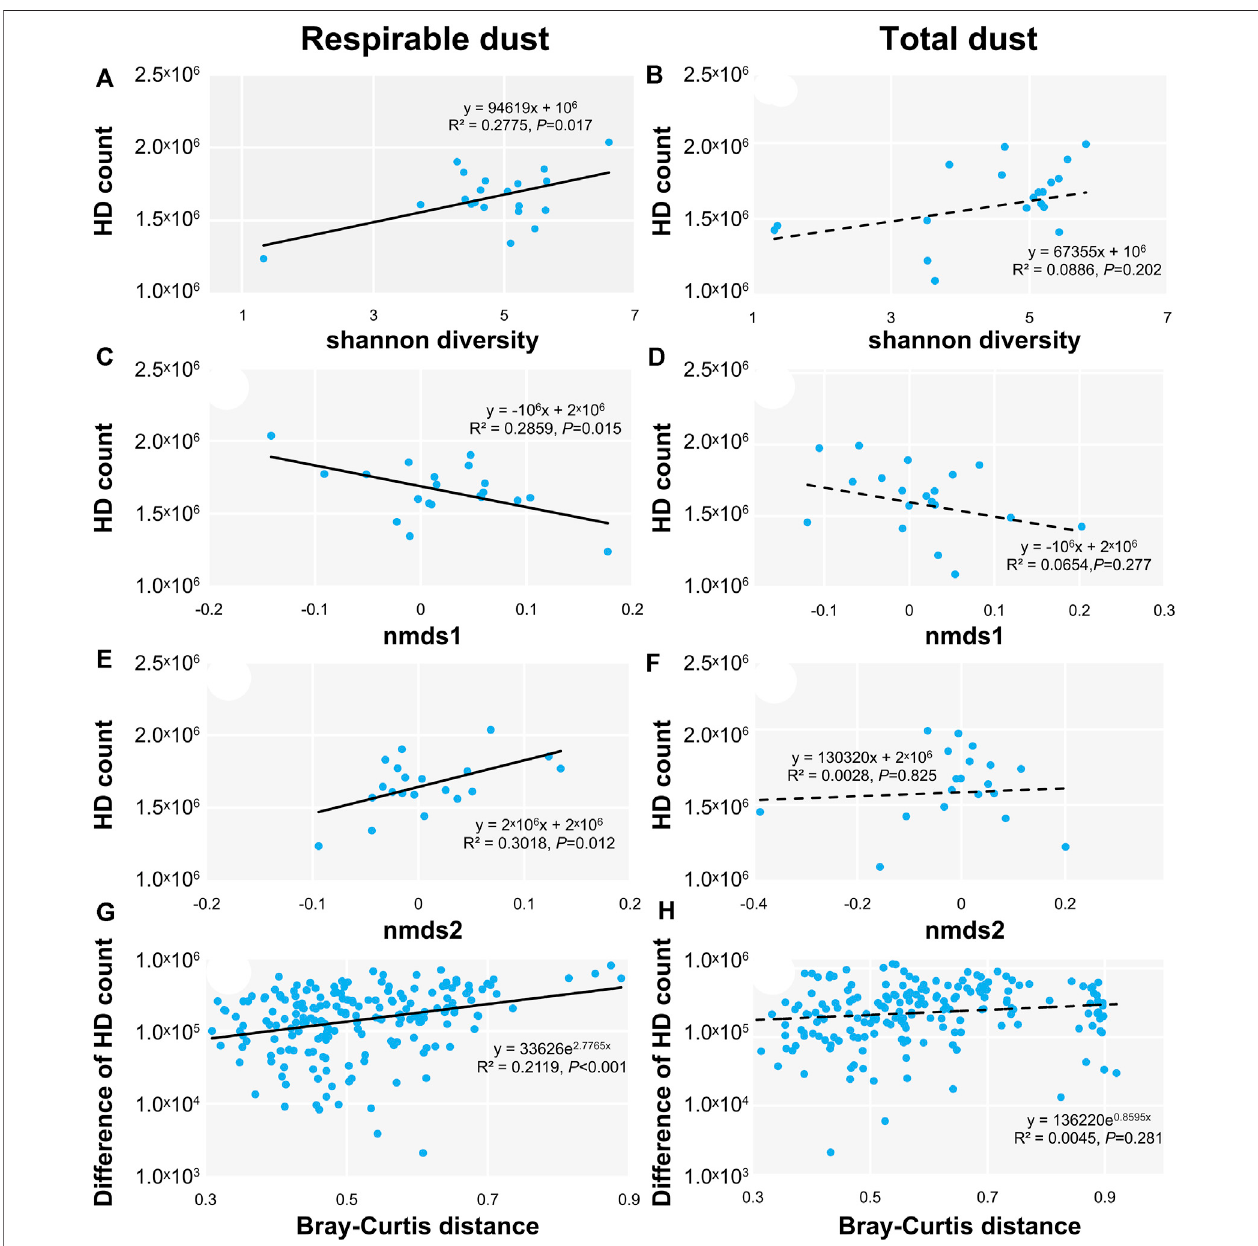
FIGURE 3 | The relationship between the human diseases (HD) count and shannon diversity, the fi rst two axes of NMDS in respirable dust (A,C,E) and total dust (B,D,F) ; the relationship between the different of HD count and the bacterial Bray-Curtis distance in respirable dust (G) and total dust (H) .